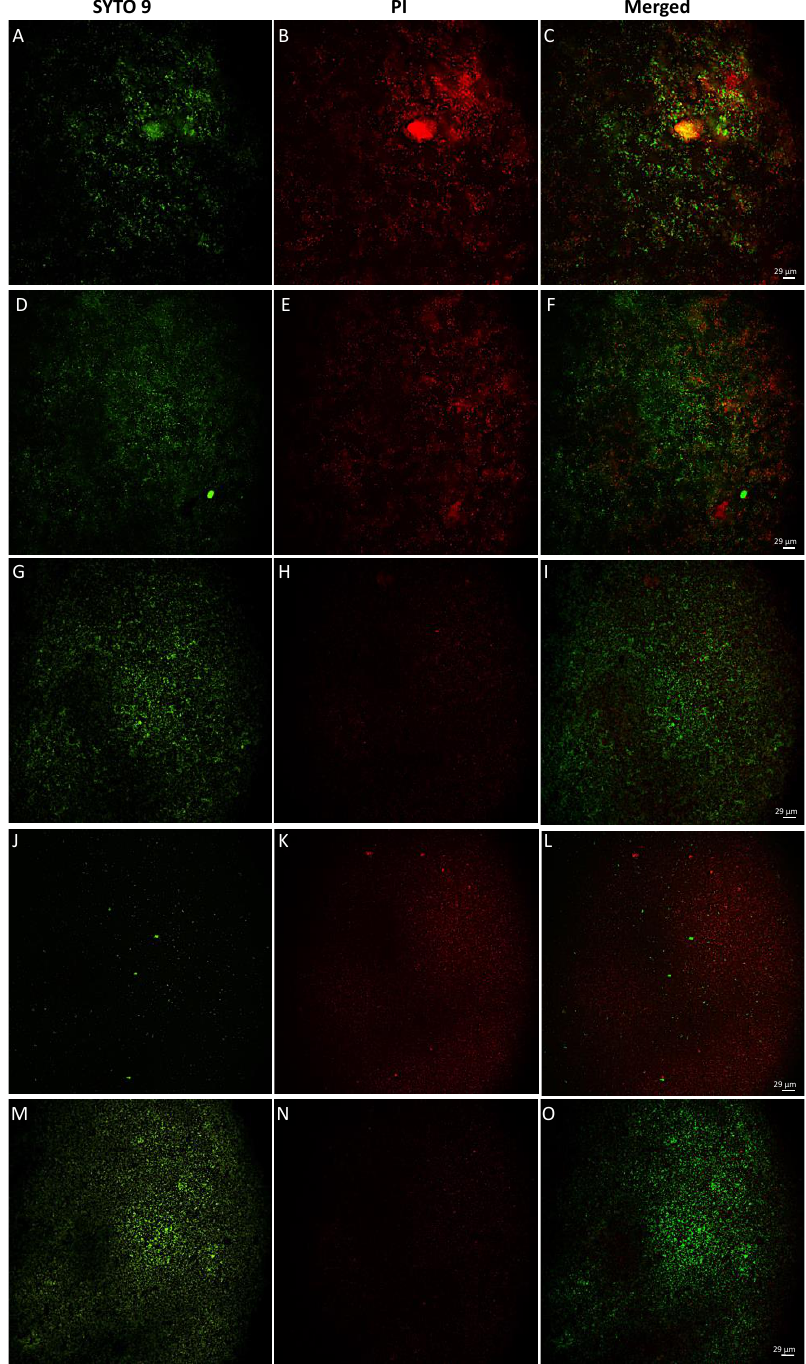
Figure 5. C. acnes LIVE/DEAD BacLight staining after treatment with Arctostaphylos uva-ursi leaf extract observed under a fluorescence microscope: ( A – C ) treatment at 1.2 mg/mL; ( D – F ) treatment at 0.6 mg/mL; ( G – I ) treatment at 0.3 mg/mL; ( J – L ) treatment with vancomycin at 5 μg/mL; ( M – O ) untreated bacteria.